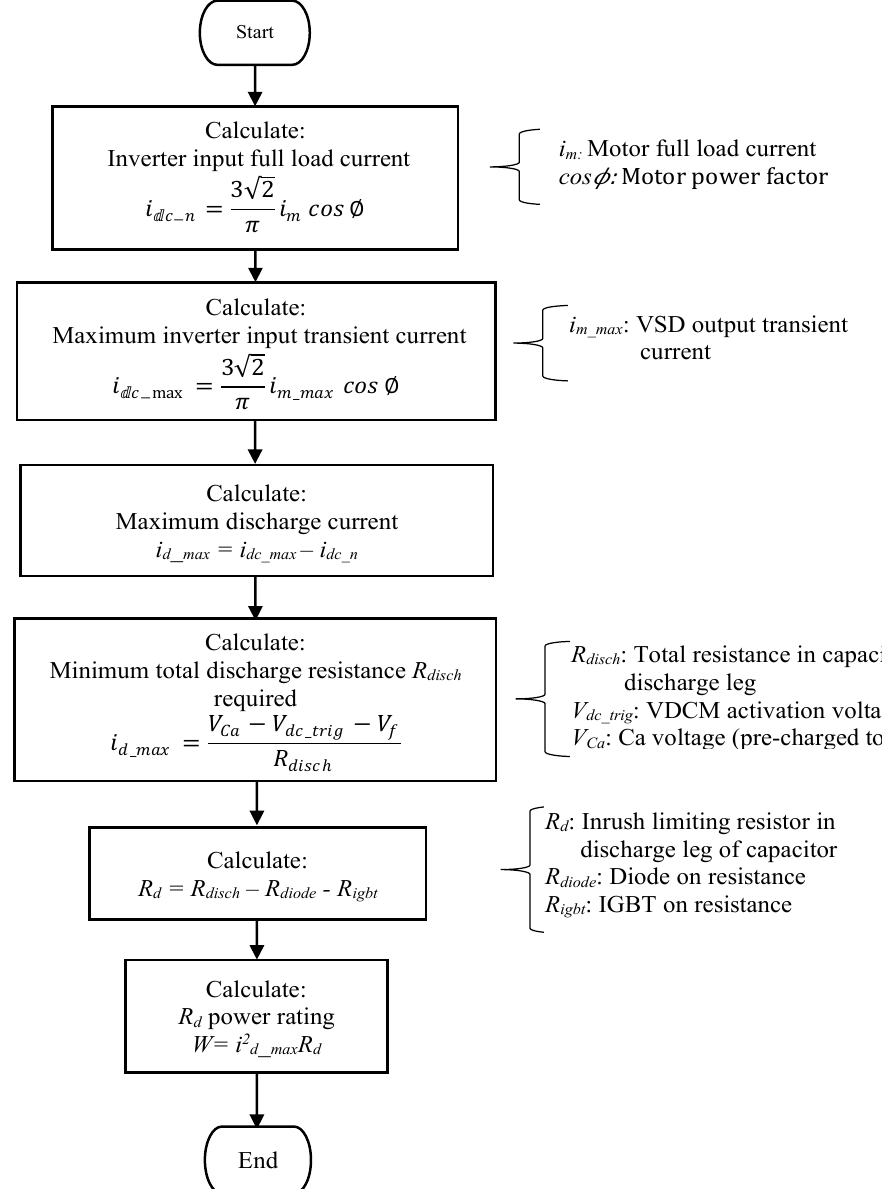
Figure 4. Discharge inrush current limiting resistor sizing flow chart.